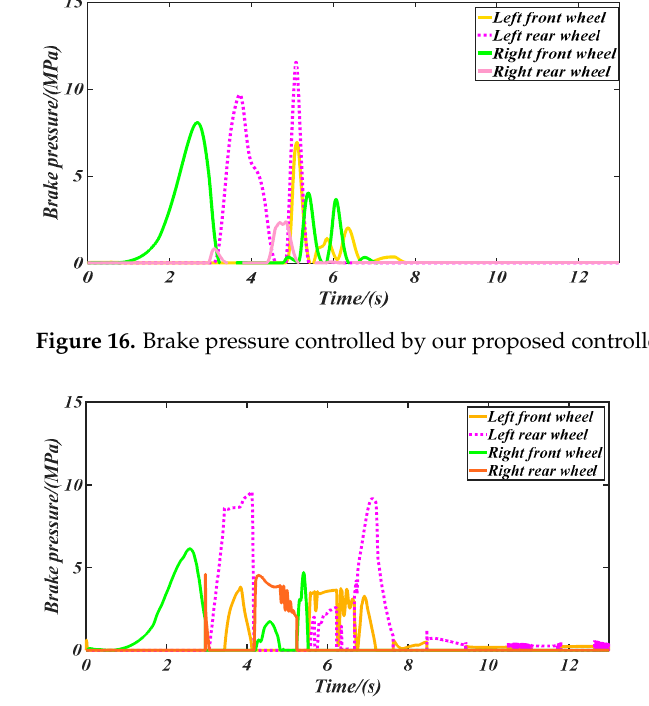
Figure 17. Brake pressure controlled by conventional LKS + DYC.